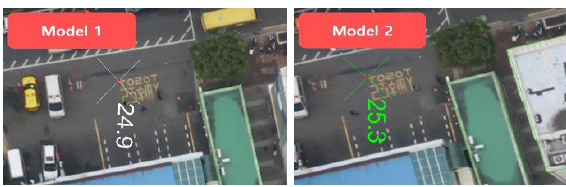
Figure 13. Areas with low vertical accuracy between different models